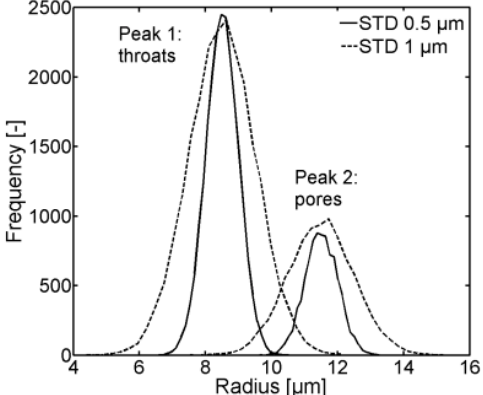
Figure 2. Representative pore size distribution (PSD) of the pore networks (PNs) studied in the pore network Monte Carlo simulations (PNMCSs) in Section 3.1. The PN with low standard deviation (STD) of pore and throat sizes is denoted STD 0.5 µm, and the PN with a higher standard variation is denoted STD 1 µm (refer to discussions below in Section 3.1). The first peaks correspond to the sizes of throats and the second peaks to the pore sizes, respectively. Note that the overlap of pore and throat sizes is greater for a higher standard deviation. The porosity of both PNs is 21%.